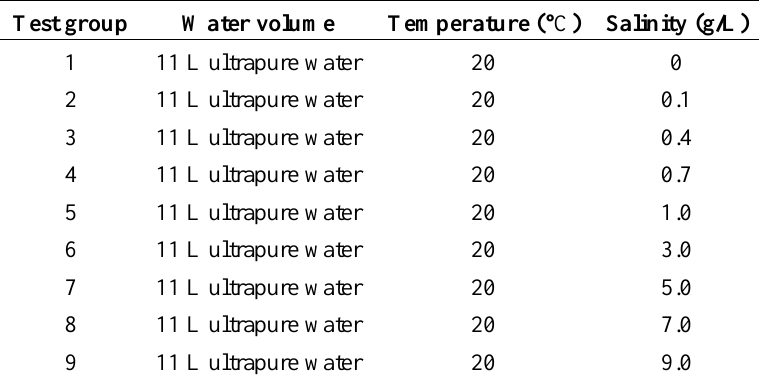
Table 1. Different test groups for generating